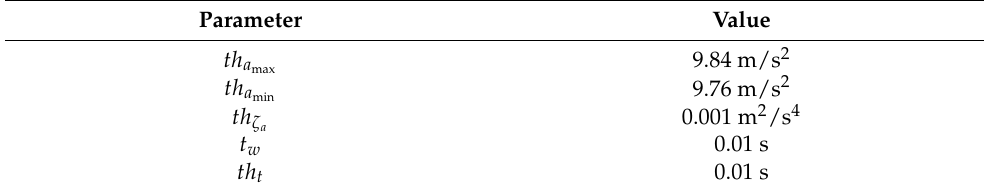
Table 1. Parameter values of zero-velocity